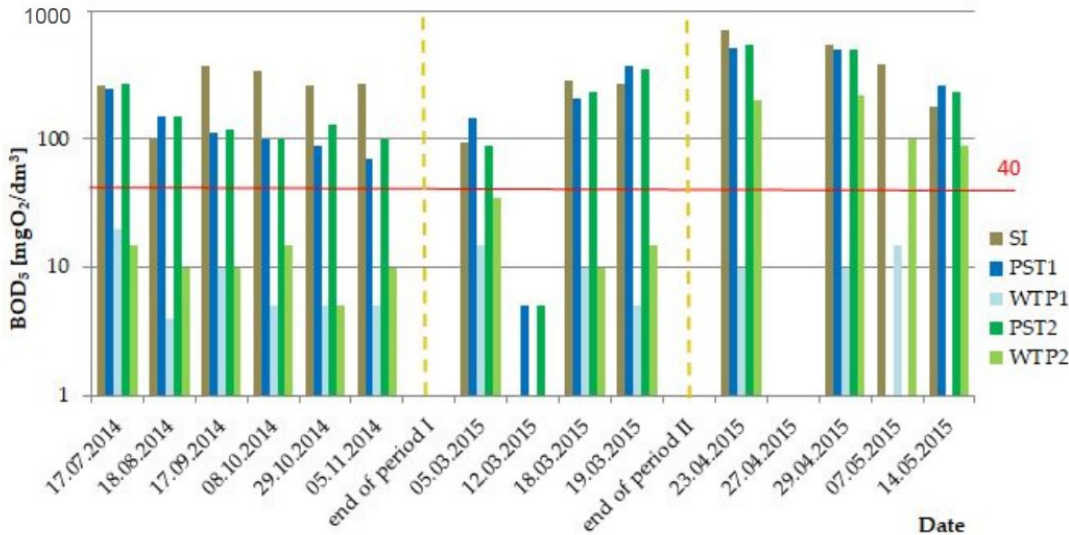
Figure 2. Biochemical oxygen demand (BOD 5 ) in sewage inlet (SI), after primary settling tank (PST1 and PST2), and after WTP1 and WTP2.